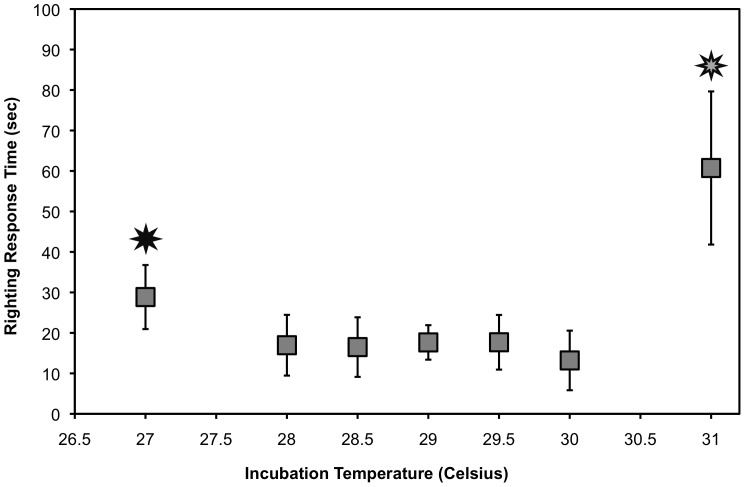
Mean Righting Response time ± S.E.M. in 2011, demonstrating that hatchlings incubated at 27°C and 31°C take significantly longer to right themselves than hatchlings from the middle range of incubation temperatures (F2,6 = 2.969, p = 0.01).Hatchlings from 31°C also took significantly longer to right themselves than hatchlings from 27°C. Stars denote statistical significance. [Sample size: 27°C n = 5; 28°C n = 5; 28.5°C n = 12; 29°C n = 15; 29.5 n = 11; 30°C n = 6; 31 n = 4].